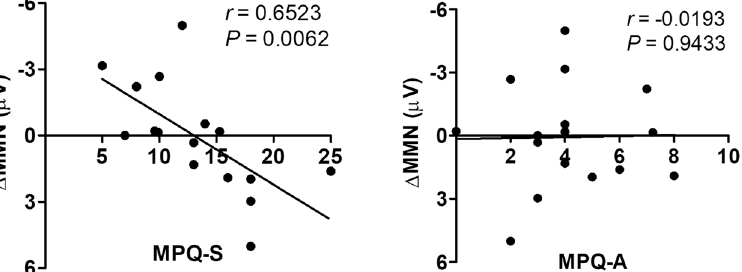
Figure 3. Correlation between MPQ subscale scores and MMN amplitude reduction across ISI conditions in TN patients. The sensory (left panel), but not the affective (right panel), subscale of the MPQ correlated with MMN amplitude